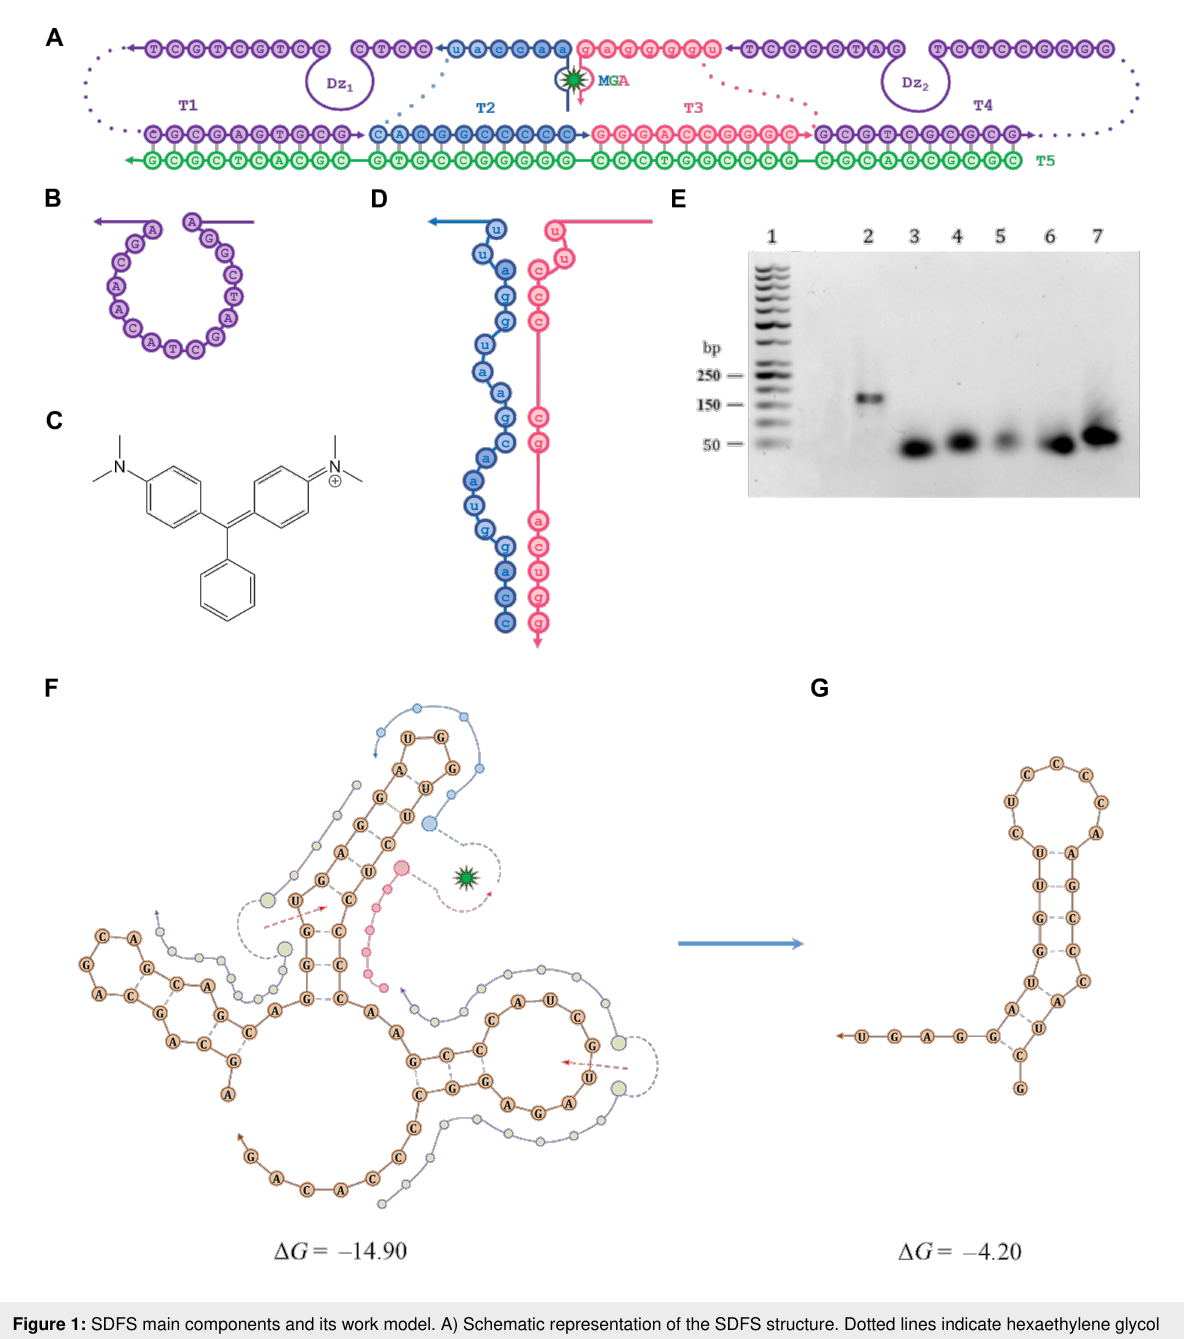
(Figure 1A, T5 strand), that combined the components into a single structure. The T1–T4 strands were connected with the platform by polythymidine or hexaethylene glycol linkers,